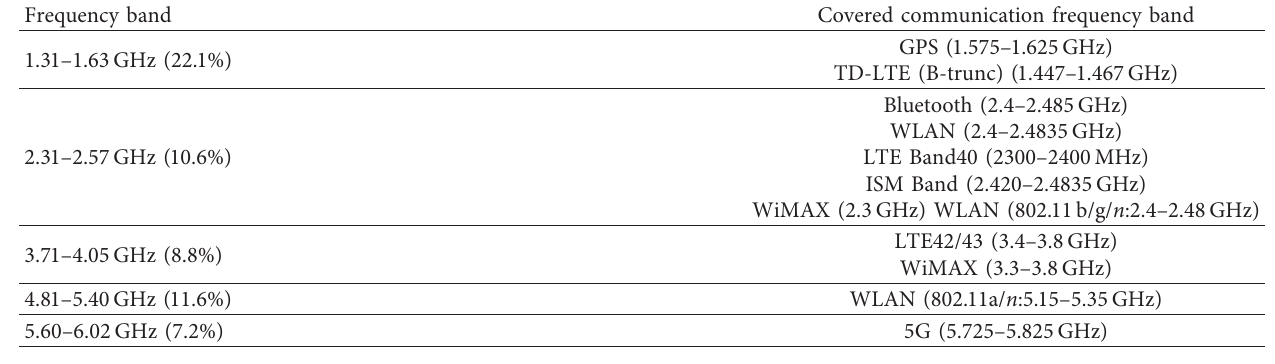
Table 2: Antenna coverage frequency band.